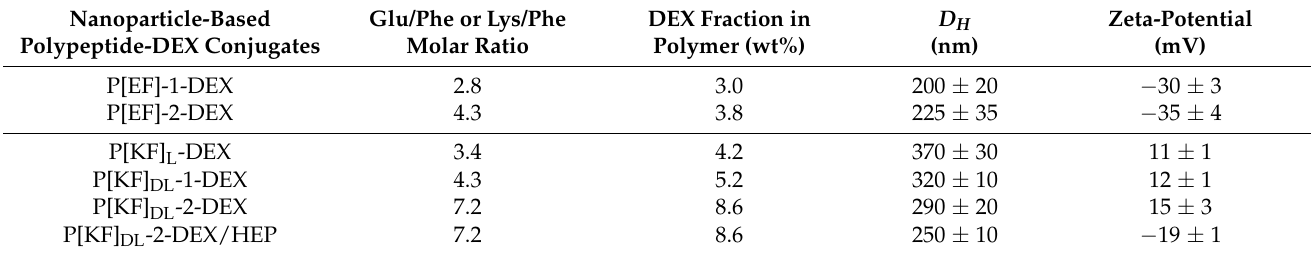
Table 4. The characteristics of the synthesized nanoparticle-based DEX-polypeptide conjugates. Nanoparticle-Based